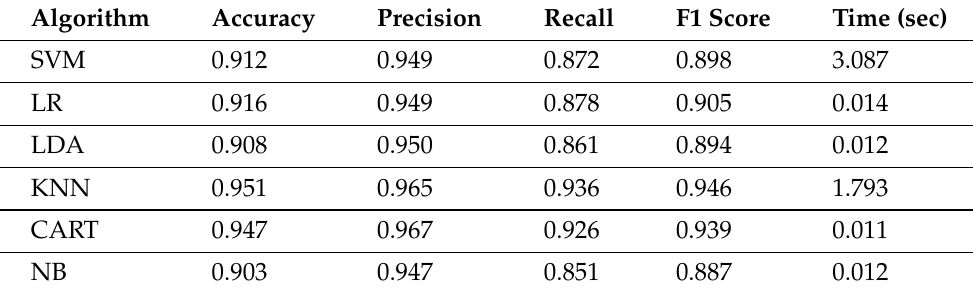
Table 1. Results using the Feature Importance feature selection method.